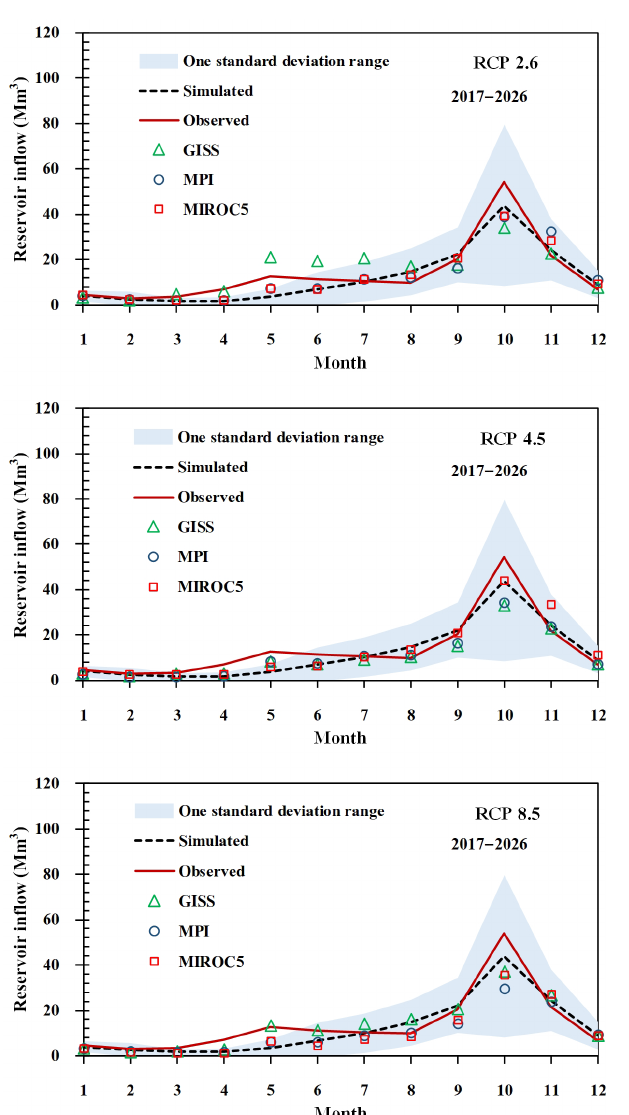
Figure 7. Comparison of mean temperature variation in during the periods of 2027–2036 (under the climate change scenarios) and 1991–2000.